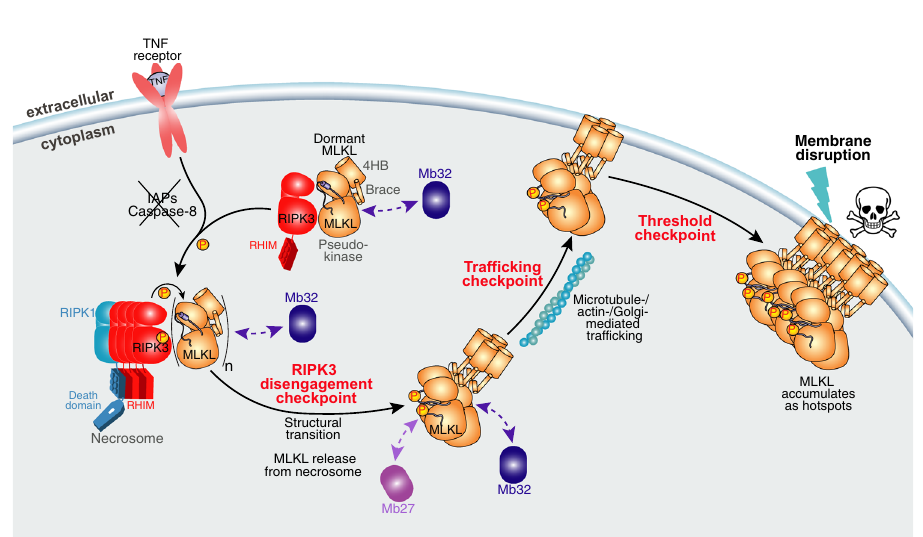
Fig. 4 Mutation of MLKL R292 and T374 in the Mb27 binding epitope inhibits necroptosis. a Sequence alignment of human and mouse MLKL pseudokinase domains. Residues of mouse MLKL that interact with RIPK3 in the MLKL:RIPK3 complex structure (PDB accession 4M69 47 ; as predicted by PDBePISA 46 ) in red text; key structural elements in teal; activation loop residues phosphorylated by RIPK3 in green. b The mouse MLKL pseudokinase domain (cyan):RIPK3 kinase domain (purple) co-crystal structure (PDB accession 4M69) 47 with non-conserved residues in human MLKL and RIPK3 in red and yellow, respectively. c , d The human MLKL:Mb27 structure was superimposed on the mouse MLKL:RIPK3 complex structure (PDB 4M69), with Mb27- proximal residues identi fi ed for characterization in e shown as sticks ( c ). d The Mb27-binding interface on the human MLKL pseudokinase (cyan surface), residues within 4.5 Å of the superimposed mouse RIPK3 kinase domain (PDB 4M69) (purple surface) and overlapped residues in the Mb27- and mouse RIPK3-epitopes, V371, K372, S373, and S417 (orange surface) are shown. The α C helix (yellow), and previously implicated RIPK3-interacting regions of human MLKL, the activation loop (green) and F386 (blue sticks) 17,35 , and T374 implicated herein, are highlighted. e Evaluation of necroptotic signaling by wild-type and Mb27 binding epitope mutants of full-length human MLKL in MLKL − / − HT29 cells. Wild-type or mutant human MLKL expression was induced with doxycycline (Dox) and cell death was measured by SYTOX Green uptake (1/mm 2 ) quanti fi ed using IncuCyte S3 live cell imaging in the presence or absence of a necroptotic stimulus (TNF, Smac mimetic, IDN-6556; TSI) for 20 h. Two independent cell lines were generated for WT, S239A, Q236A, and one for other MLKL mutants; WT lines were assayed in n = 5 independent experiments. TSEE, R333A and one independent Q236A line were assayed in n = 4 independent experiments; other mutants in n = 3 independent experiments. Data are plotted as mean ± SEM. f Alanine substitution of MLKL R292 likely disrupts key interactions with neighboring residues. g Wild-type and R292A, but not T374D, human MLKL expressed in MLKL − / − HT29 cells were phosphorylated in response to 3 h TSI treatment. Data are representative of duplicate independent experiments.